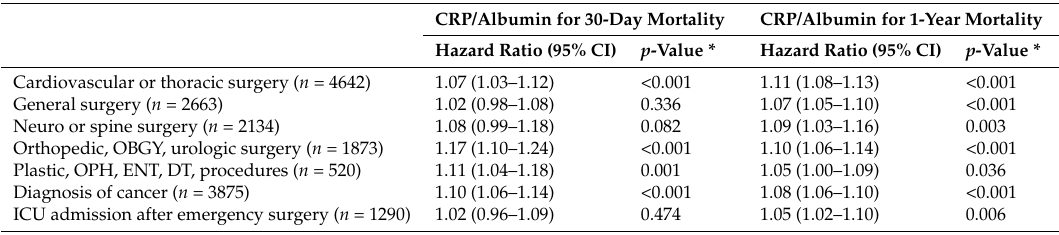
Table 4. Subgroup analysis according to type of surgery, diagnosis of cancer, and ICU admission after emergency surgery for 1-year and 30-day